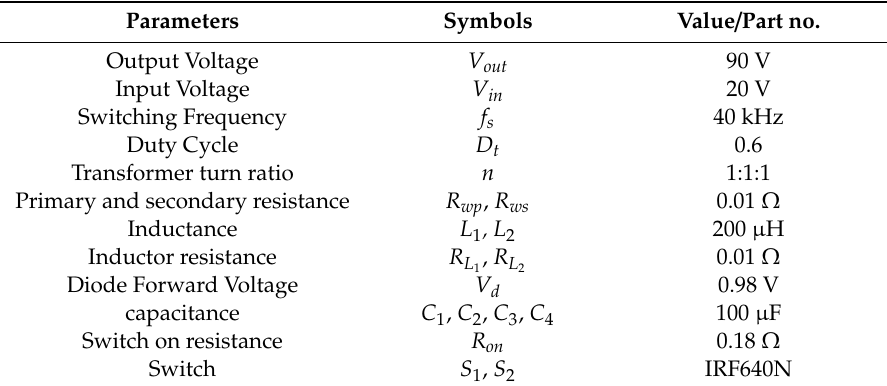
Table 2. Prototype and Simulation